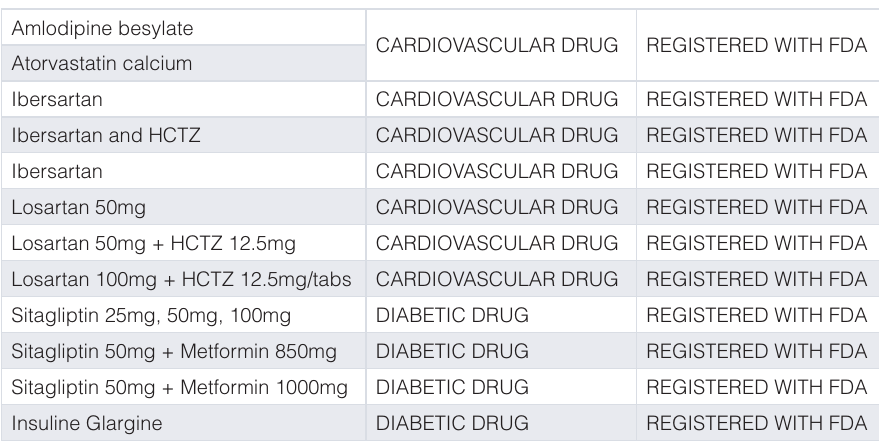
Table 2. List of innovator